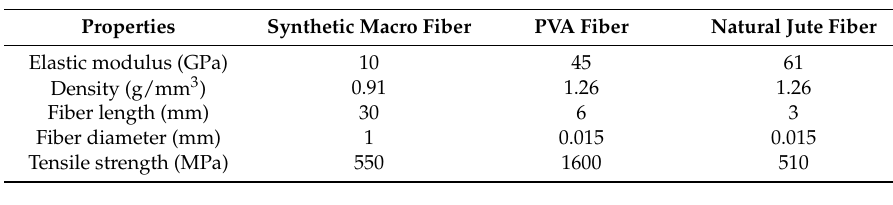
Table 5. Properties of fibers.